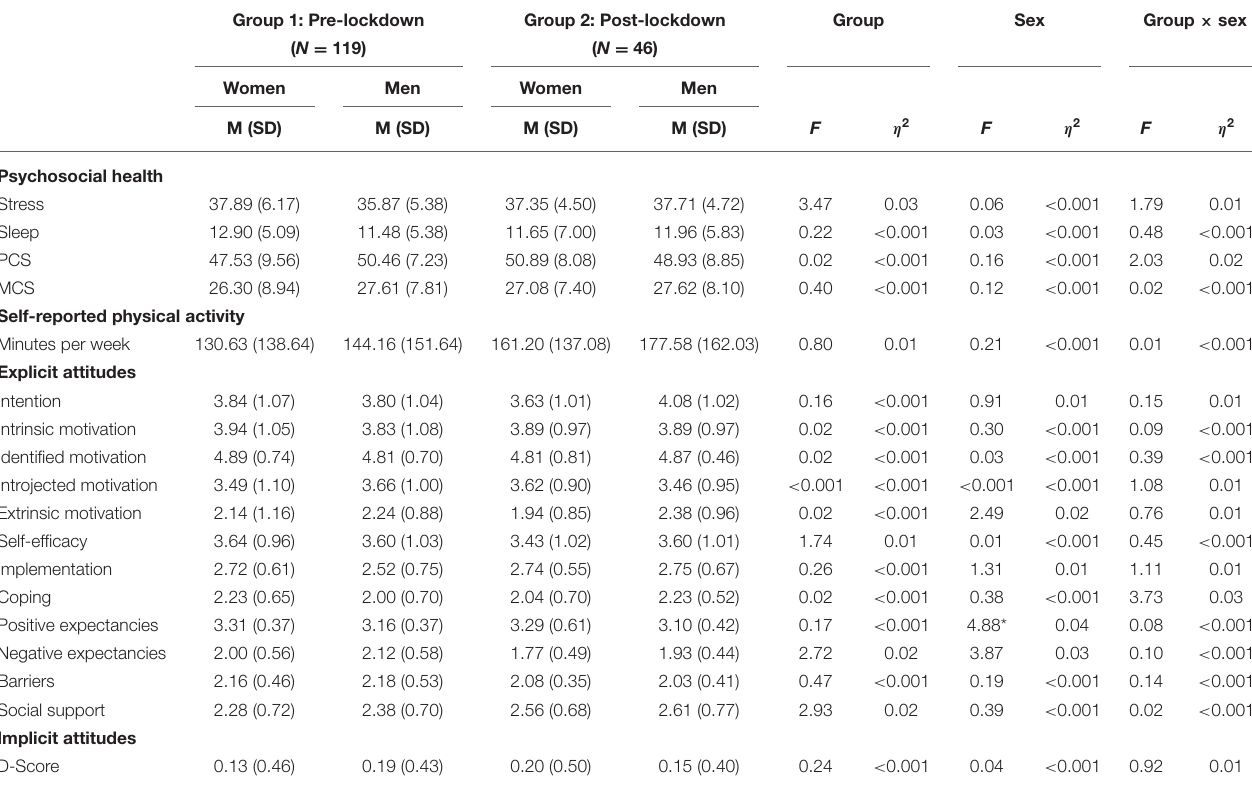
TABLE 4 | Between-group differences in psychosocial health, self-reported physical activity and explicit/implicit attitudes toward physical activity, with group by sex